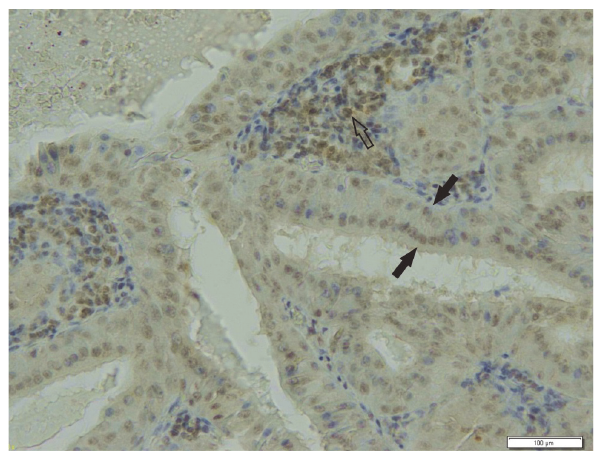
Fig. 6. Oncocytoma. Moderate VEGF-D immunostaining in the nuclei of the major- ity of oncocytes (black arrow). Weak cytoplasmatic reaction is focally present in some cells. Negatively stained cells are rare (white